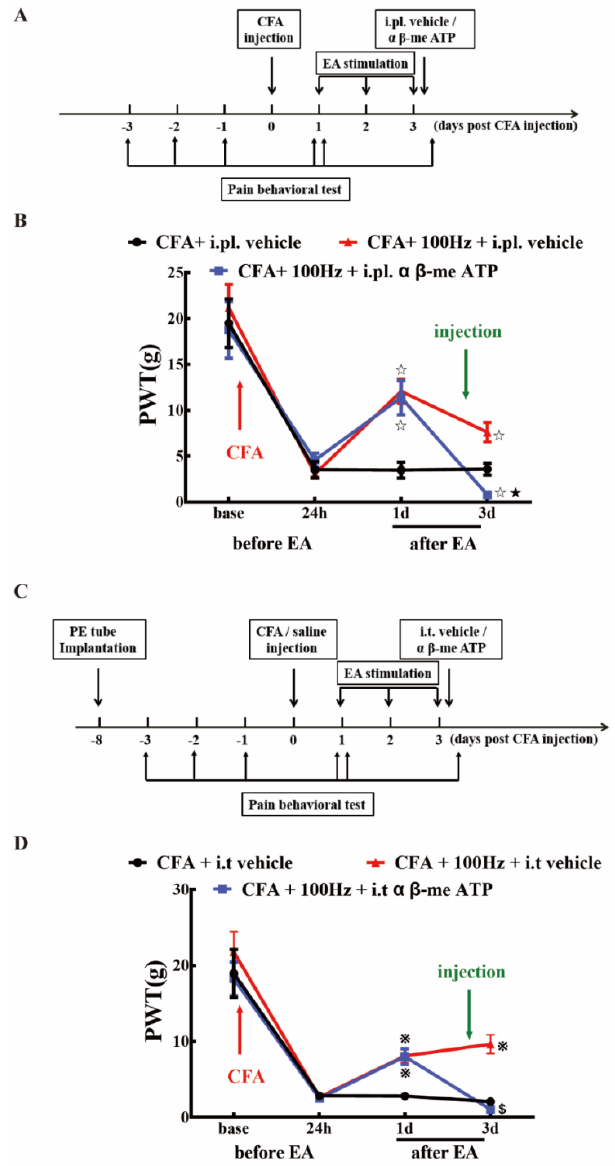
Figure 9. α β -me ATP (P2X3 agonist) attenuated the analgesic e ff ect of 100 Hz EA on PWT in CFA rats. ( A ) Schematic flow diagram of the intraplantar injection of α β -me ATP. ( B ) The analgesic e ff ect of 100Hz EA can be attenuated by intraplantar injection of α β -me ATP. Data are presented as the mean ± SEM, n = 6. ☆ P < 0.05, compared with the CFA + i.pl. vehicle group; ★ P < 0.05, compared with the CFA + 100Hz + i.pl. vehicle group. ( C ) Schematic flow diagram of the intrathecal injection of α β -me ATP. ( D ) Intrathecal injection of α β -me ATP may reduce the analgesic e ff ect of 100 Hz EA. Data are presented as the mean ± SEM, n = 6. ※ P < 0.05, compared with the CFA + i.t vehicle group; $ P < 0.05, compared with the CFA + 100Hz + i.t vehicle group.